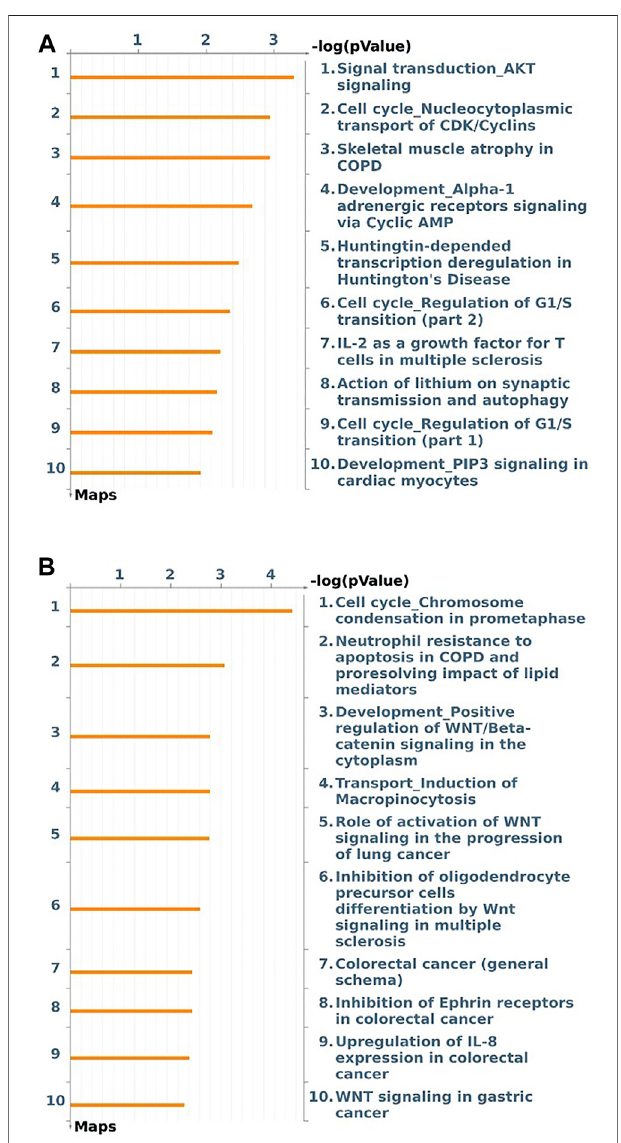
FIGURE5| Top10pathway mapsenriched forthegenesregulatedand containing the eQTL encompassing relevant QTL regions associated with intramuscular fat content (IMF) (A) and backfat thickness (BFT) (B) in aNellore cattle population.